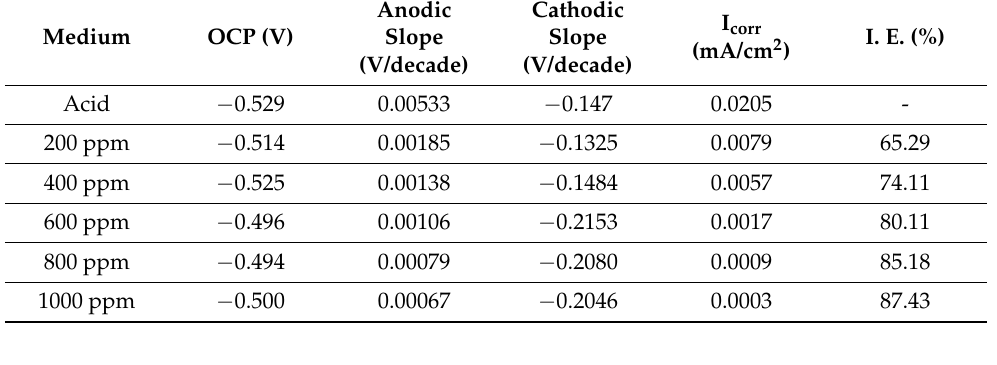
Table 3. Anodic and cathodic slope and inhibition efficiency for as-immersed sample.